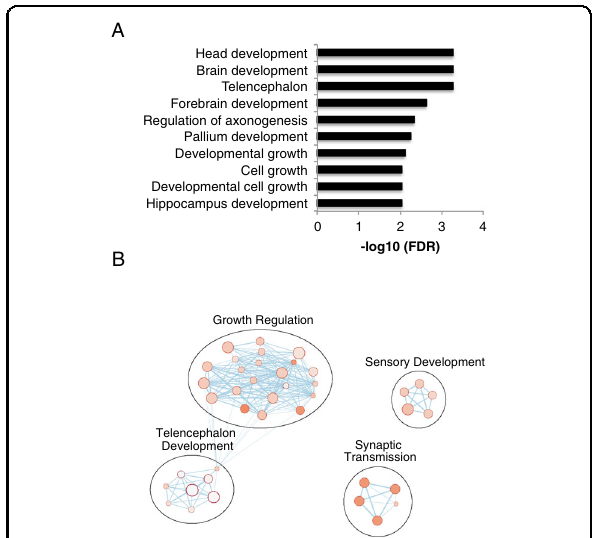
Fig. 4 Gene ontology analysis of 134 genes whose methylation status was altered by prenatal sGC treatment in both the hippocampus and whole blood. A Top ten enriched GO terms identi fi es an enrichment for annotations associated with neurodevelopment. B Cytoscape image of enriched GO terms (57 terms) clustering based on shared gene pathways among terms. FDR p -values are color-coded in orange inside a node, with lighter nodes indicating lower FDR p -values). The size of each node represents the number of genes involved in each GO term, with edges indicating shared genes between